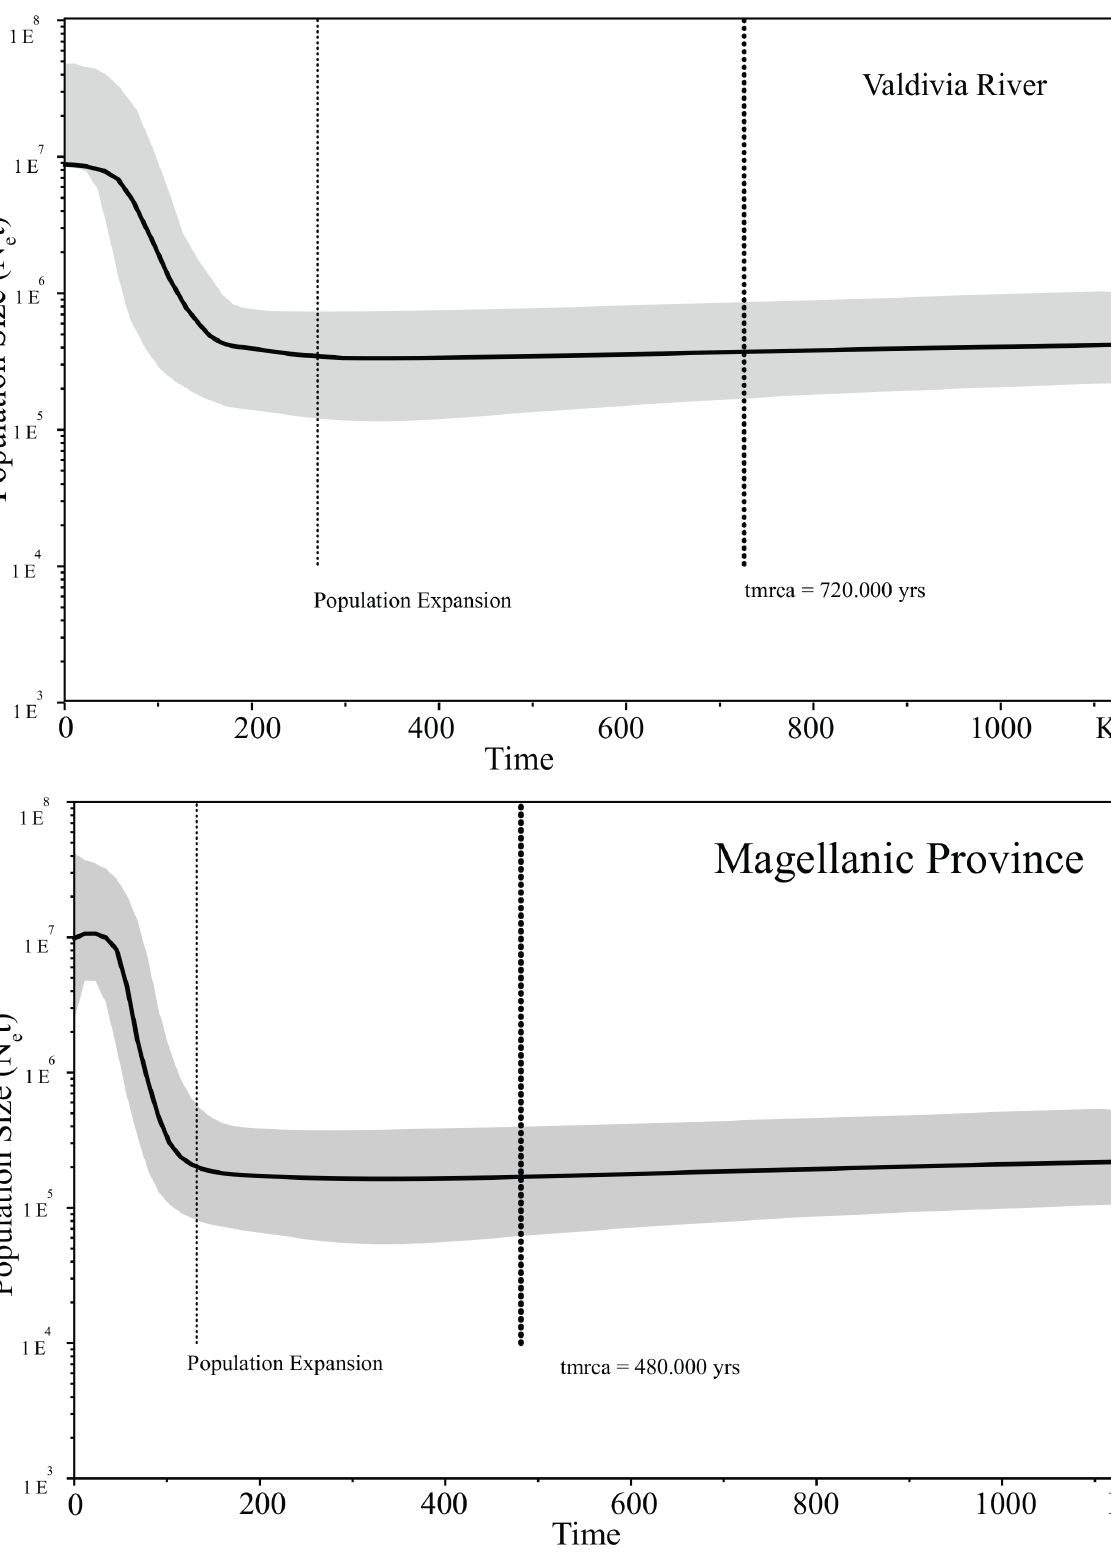
Fig 3. Bayesian Skyline plot analyses revealing the times of the most recent common ancestor (tmrca): for the Valdivia Rive (A) and Colico Lake (B) populations. doi:10.1371/journal.pone.0154766.g003 PLOS ONE | DOI:10.1371/journal.pone.0154766 May 11,